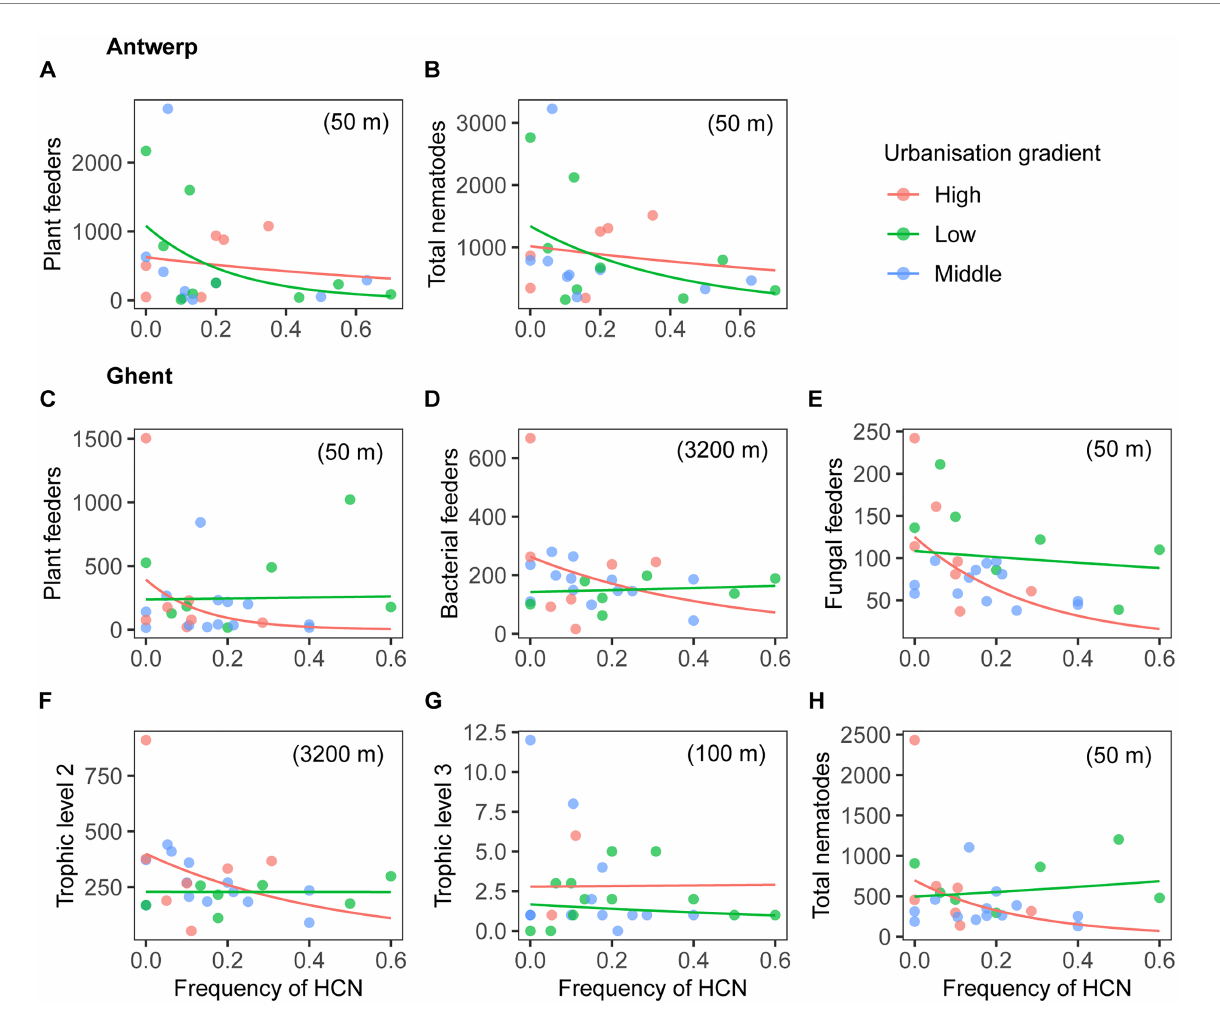
FIGURE 2 Root-associated nematode abundance as a function of urbanization gradient and frequency of HCN in the city of Antwerp (A,B) and Ghent (C–H) . Negative binomial generalized linear models were fitted, with dry weight of roots for nematode extraction as a covariate. Nematode abundances were tested regarding feeding types, trophic levels and total nematodes. Trophic level 2 is the sum of bacterial and fungal feeders; Trophic level 3 is the sum of predators and omnivores. Nematode abundance of tested groups whose models showed significant effects of at least one factor at p < 0.05 (see the detailed results, Table 1) is plotted against frequency of HCN, for a mean value of root dry biomass. To illustrate the interaction effect of urbanization and frequency of HCN, nematode abundance at low (the first quartile value, green lines) and high (the third quartile value, red lines) levels of urbanization is predicted. Similarly, data points with urbanization values lower than the first quartile, between the first and third quartile, and higher than the third quartile are indicated in green, blue, and red, respectively. The scale of urbanization at which nematode abundance was best explained by urbanization and frequency of HCN is shown in between